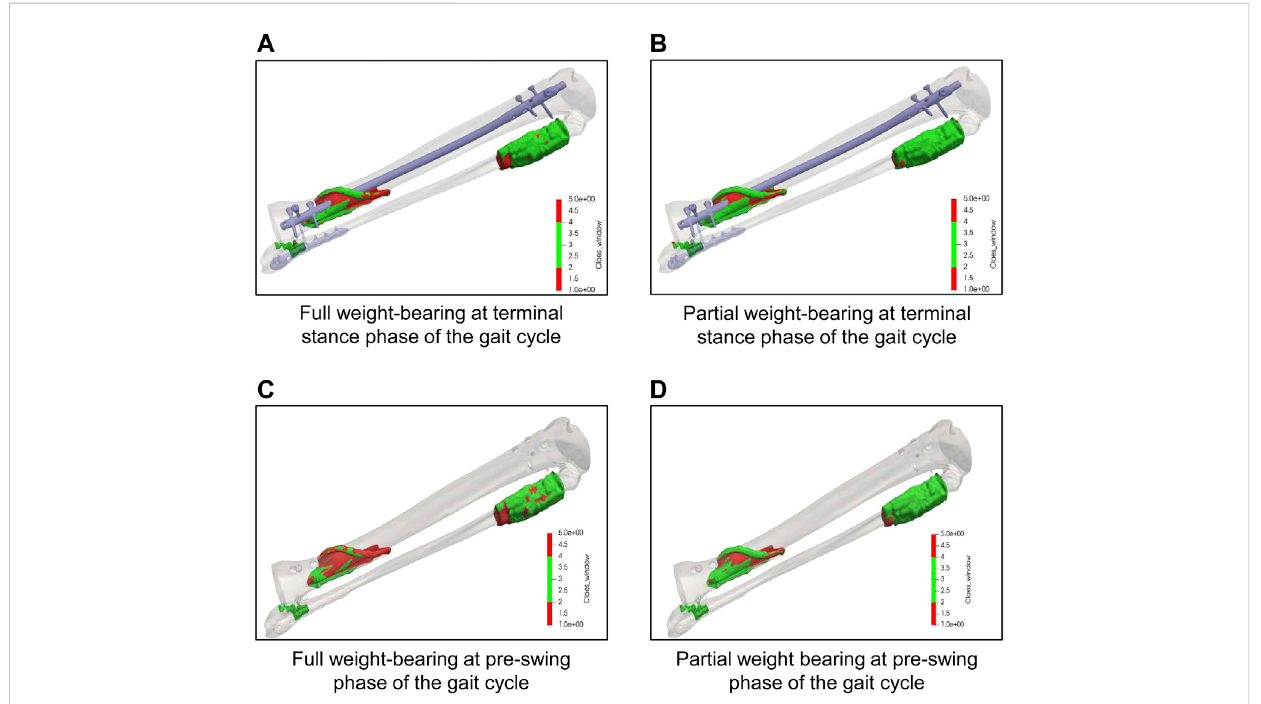
FIGURE 5 Results of simulation with different weight-bearings on the interfragmentary strain in the tibia. (A , B) : Simulation of elements within the fracture gap of the tibia at the terminal stance phase during the gait cycle under full weight-bearing (A) and partial weight-bearing of 20 kg (B) demonstrating the amount and precise location of elements within (green) or outside (red) the range of regular bone healing conditions according to Claes and Heigele (1999). (C , D) : Simulation of elements within the fracture gap of the tibia at the pre-swing phase during the gait cycle under full weight-bearing (A) and partial weight-bearing of 20 kg (B) demonstrating the amount and precise location of elements within (green) or outside (red) the range of regular bone healing conditions according to Claes and Heigele (1999). Note that most of the elements out of the healing range were found to be in the dorsal aspect of the tibia fracture, which, in turn, corresponds to the clinical course of